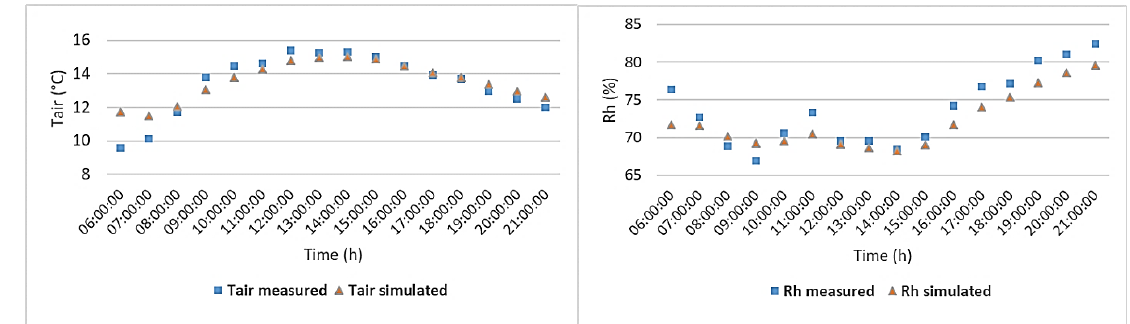
Figure 5. Time evolution of air temperature T air ( left ) and relative humidity Rh ( right ) measured and obtained from ENVI-met at the measurement position VD in San Pio (Lecce).